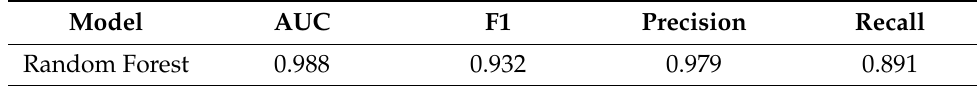
Table 6. Predictability of random